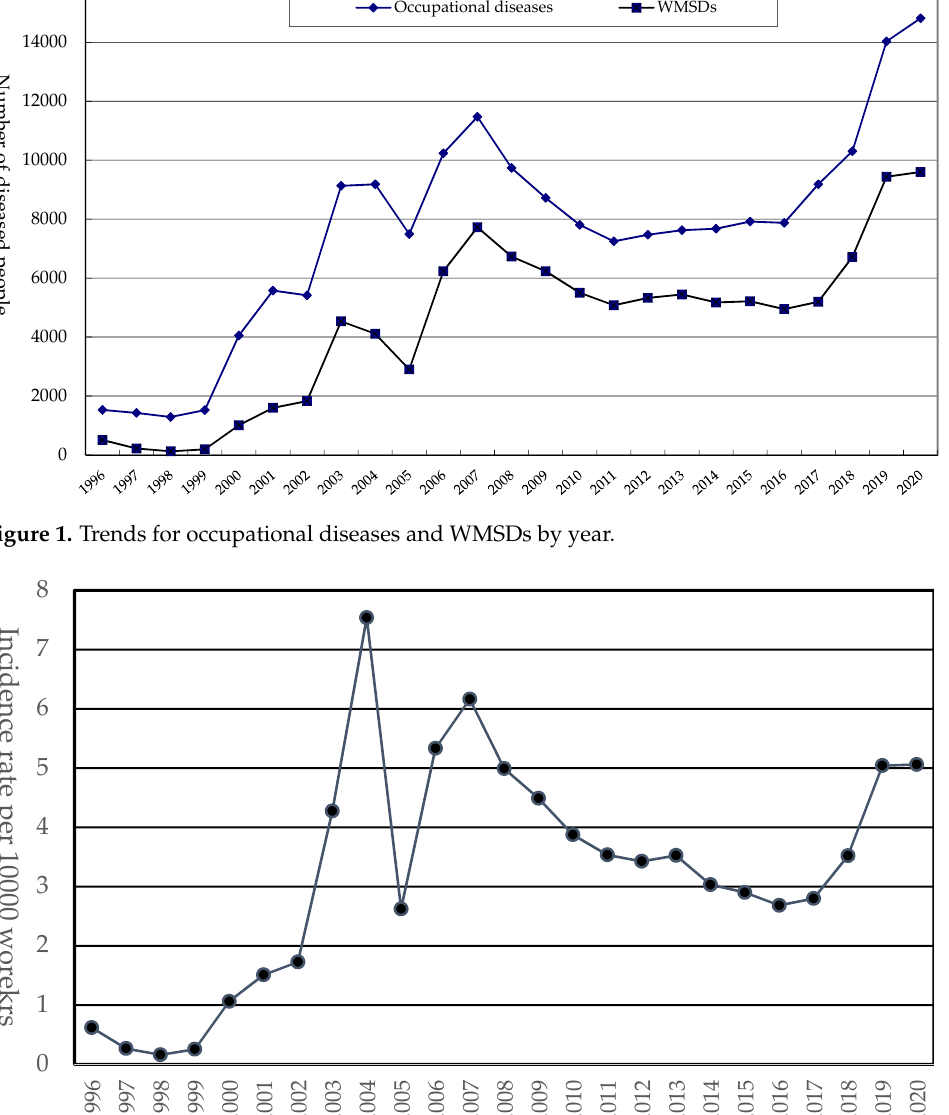
Figure 2. Incidence rates of WMSDs per 10,000 workers by year.